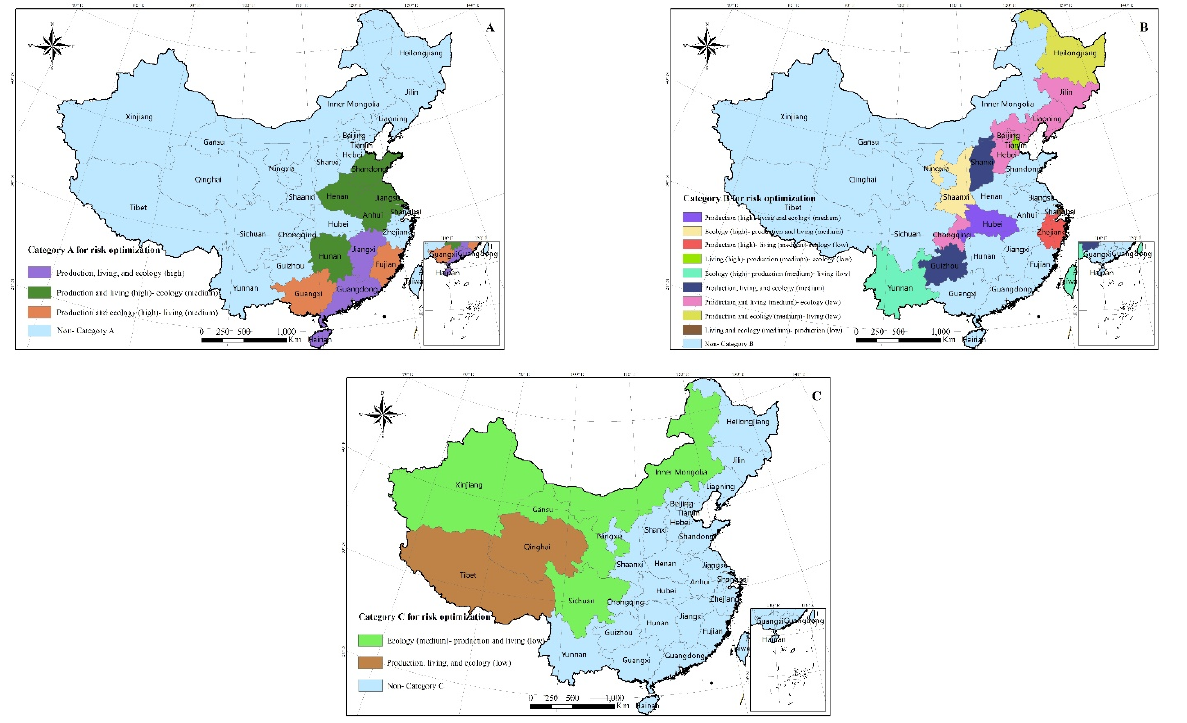
Figure 4. Distribution pattern of category A ( A ), B ( B ), and C ( C ) to cope with PLE risk.